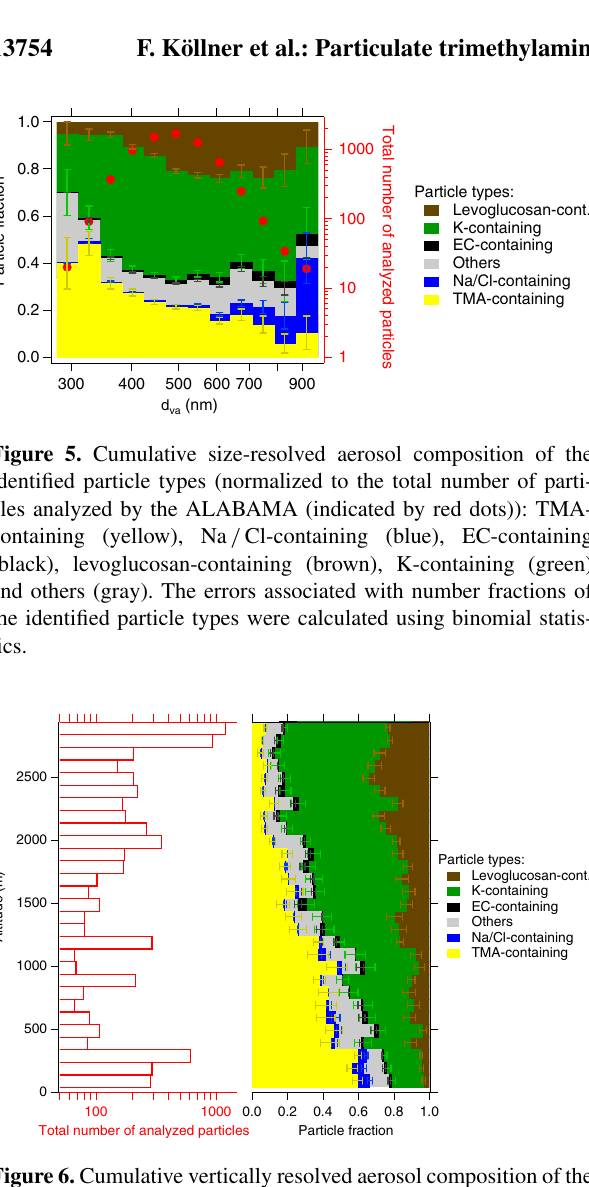
Figure 6. Cumulative vertically resolved aerosol composition of the identified particle types (normalized to the total number of parti- cles analyzed by the ALABAMA (indicated by red bars)): TMA- containing (yellow), levoglucosan-containing (brown), Na / Cl- containing (blue), EC-containing (black), K-containing (green) and others (gray). There are in general two levels (below 340m and above 2700m) with an enhanced number of particles analyzed by the ALABAMA, which is caused by a longer sampling time within these altitudes.